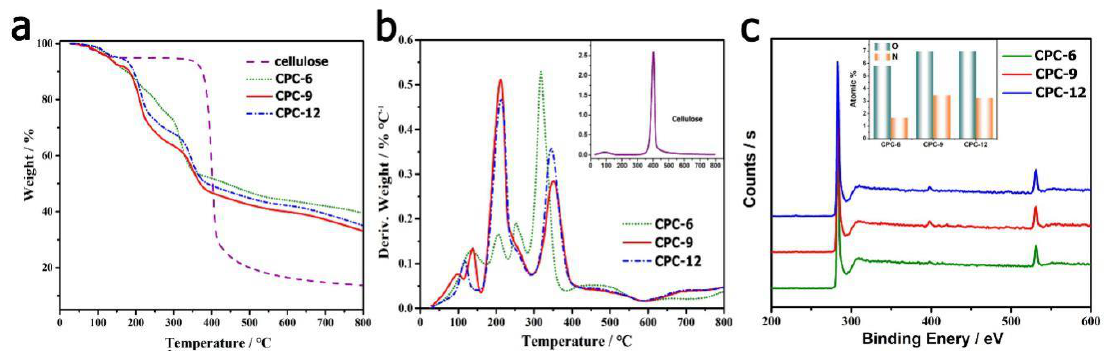
Figure 3. ( a , b ) TGA results of CPC precursors and pure cellulose, ( c ) XPS results of di ff erent CPC Figure 3. ( a, b ) TGA results of CPC precursors and pure cellulose, ( c ) XPS results of different CPC materials.